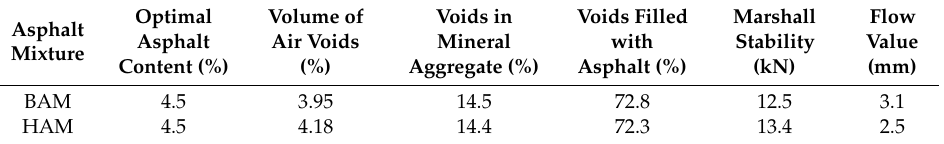
Table 3. Parameters of asphalt mixture for the Marshall design